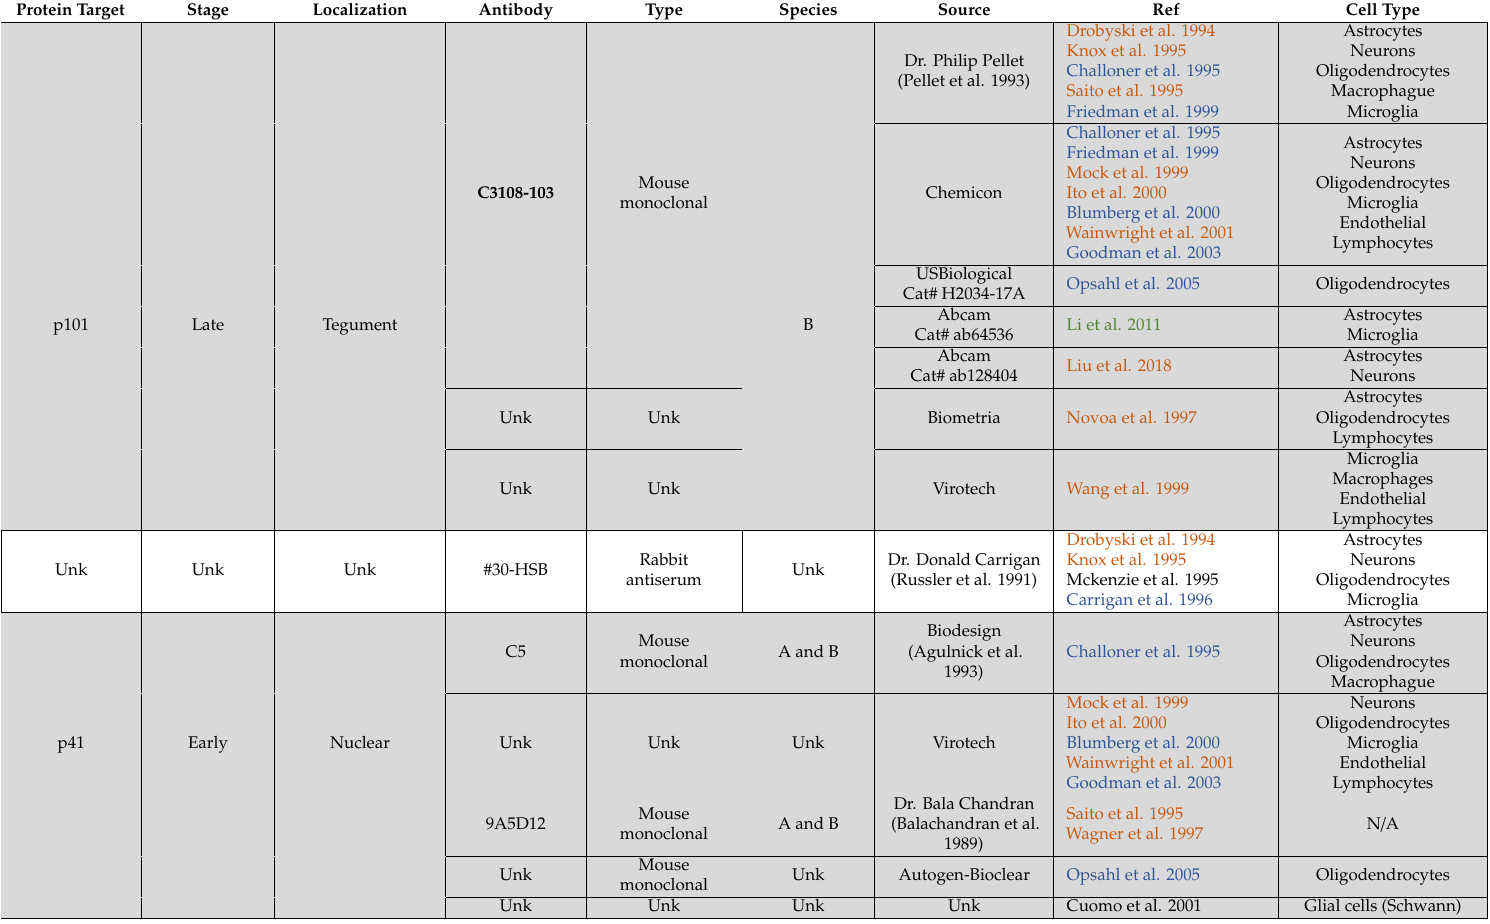
Table 1. Characteristics of the antibodies used across studies. Blue: MS; Green: TLE; Red: Encephalitis / PML; Black: Others. The color indicates the main focus of the study which may interrogate multiple